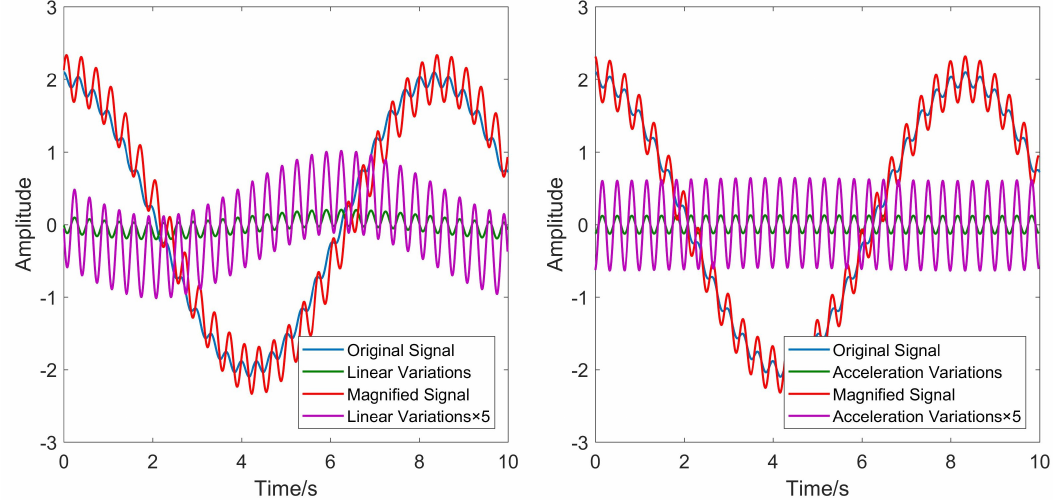
Figure 2. Comparisons between linear motion magnification and acceleration magnification